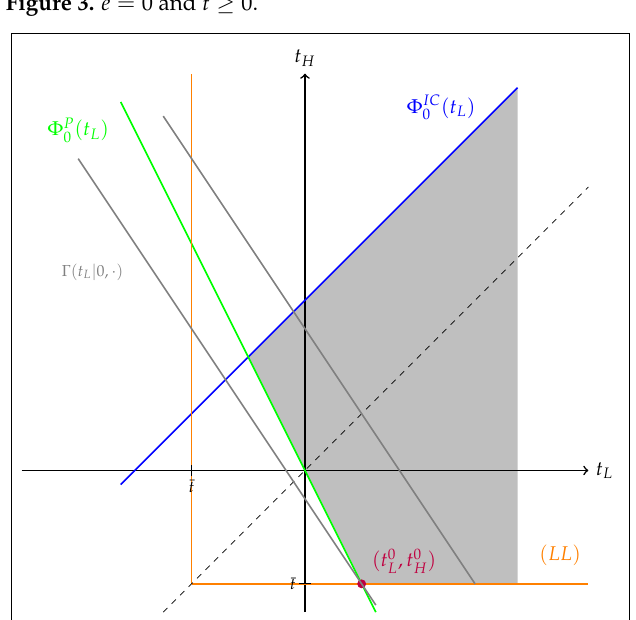
Figure 3. e = 0 and ¯ t ≥ 0.